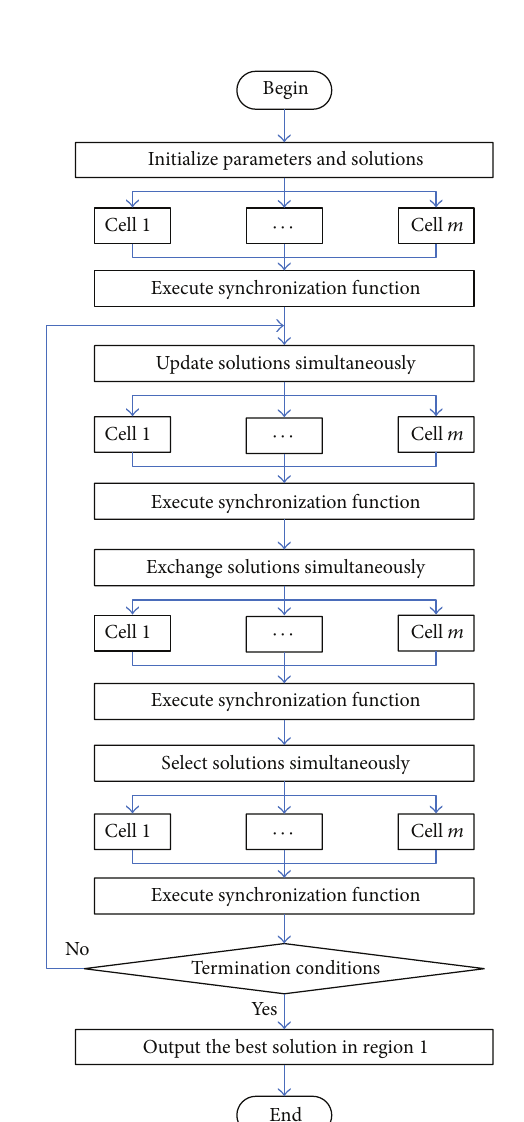
Figure 3: The GPU implementation procedure of membrane algorithms.